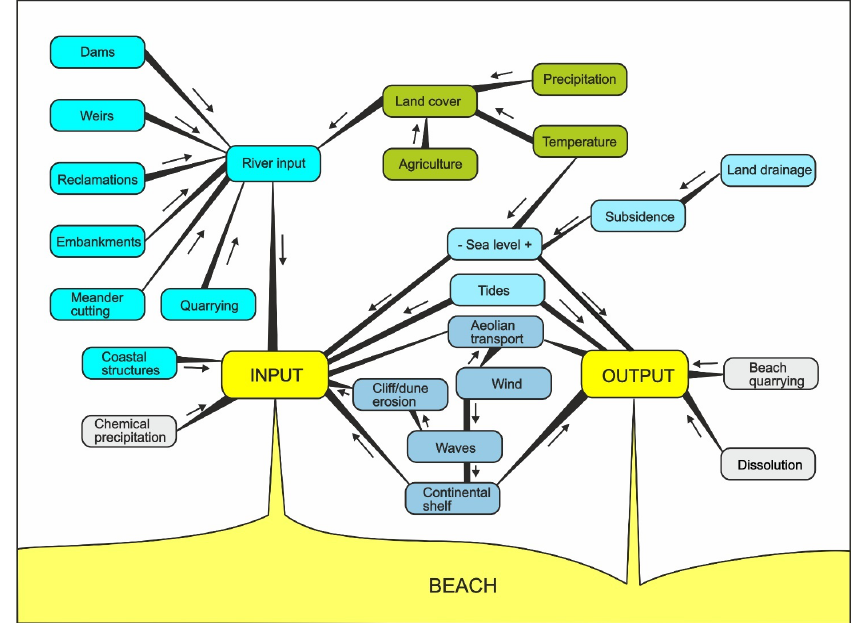
Figure 1. Schematic beach sediment budget Input and Output. Arrows show the direction of the process; connecting lines thickness increases and decreases depending on the effect (positive vs. negative) that each item has on the following one (modified from the work in [29]).